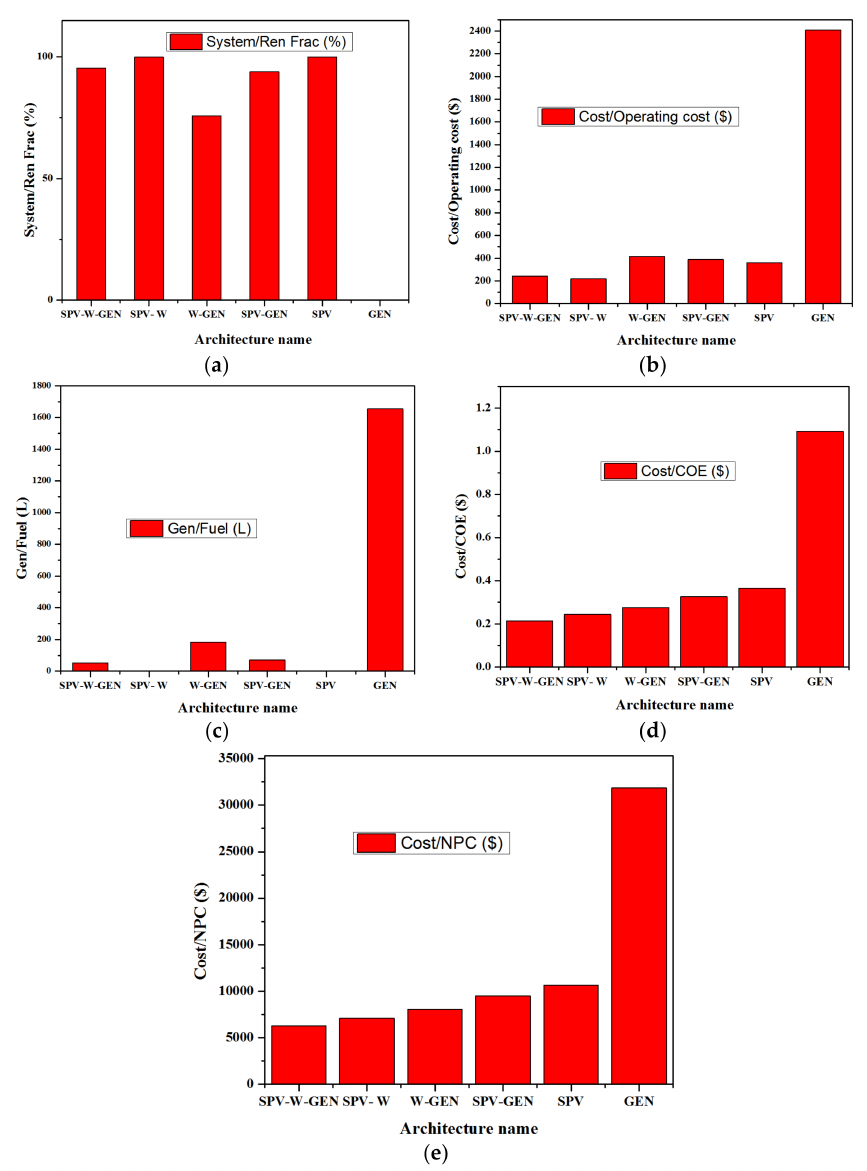
Figure 12. ( a ) percentage renewable penetration; ( b ) Operating Cost ($); ( c ) Fuel consumption; ( d ) Cost of energy (COE) and ( e ) Net Present cost (NPS) for SPV-W-GEN, SPV, SPV-W, SPV-GEN, W-GEN and